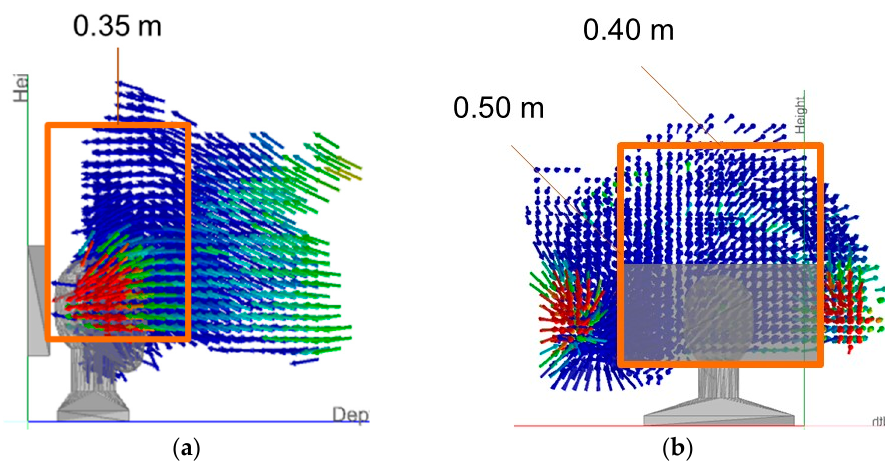
intensity map without control. ( b ) Sound intensity map with control.